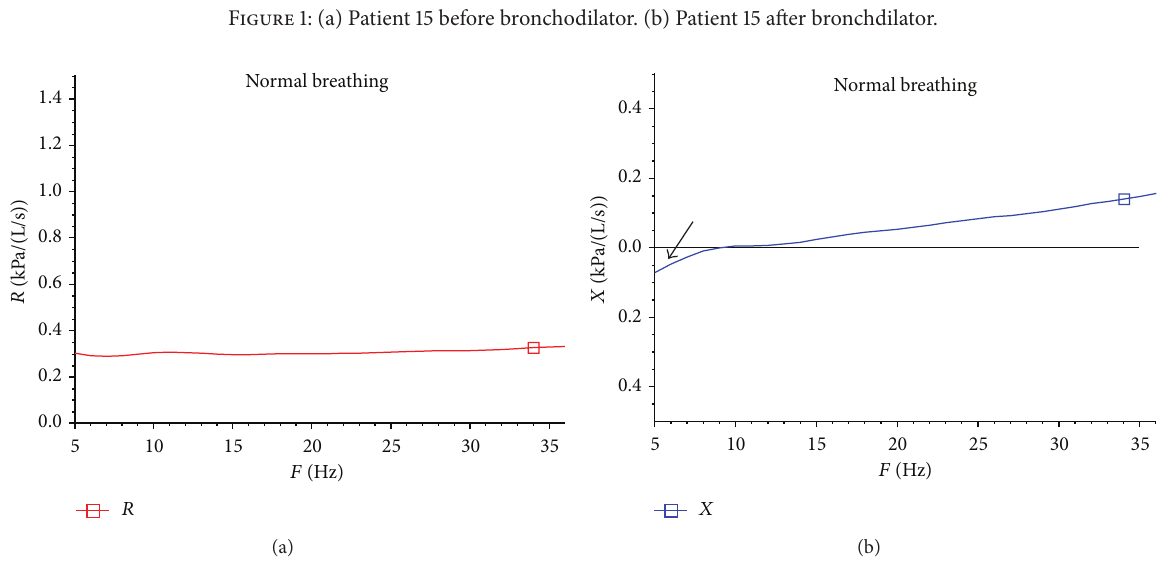
Figure 1: (a) Patient 15 before bronchodilator. (b) Patient 15 after bronchdilator.